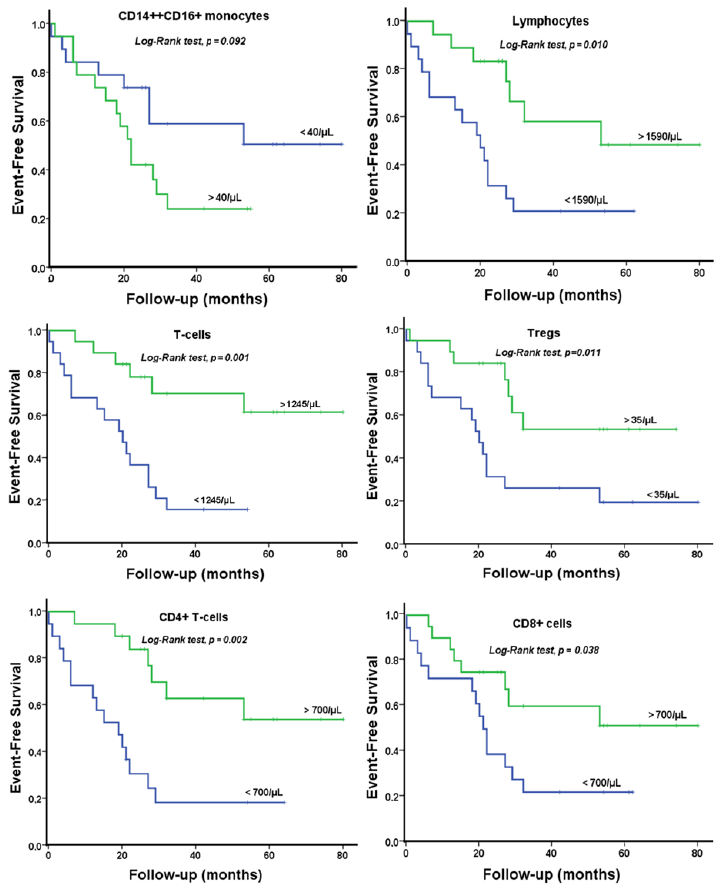
Figure 3. Kaplan–Meier curves of endpoint-free patients with circulating immune cell subset expres- sion below or above median value derived